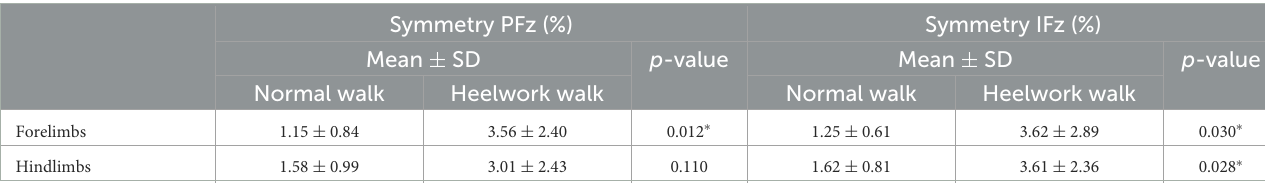
TABLE 4 Mean values, standard deviation, and significant differences of the symmetry index for the peak vertical force and vertical impulse between normal walking and heelwork walking.